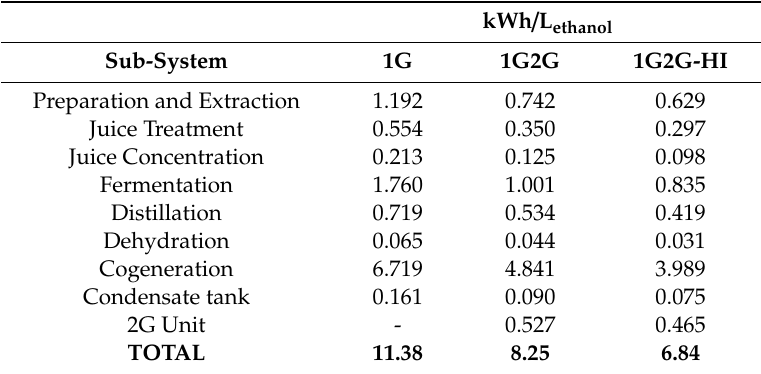
Table A18. Irreversibilities per liter of ethanol in the